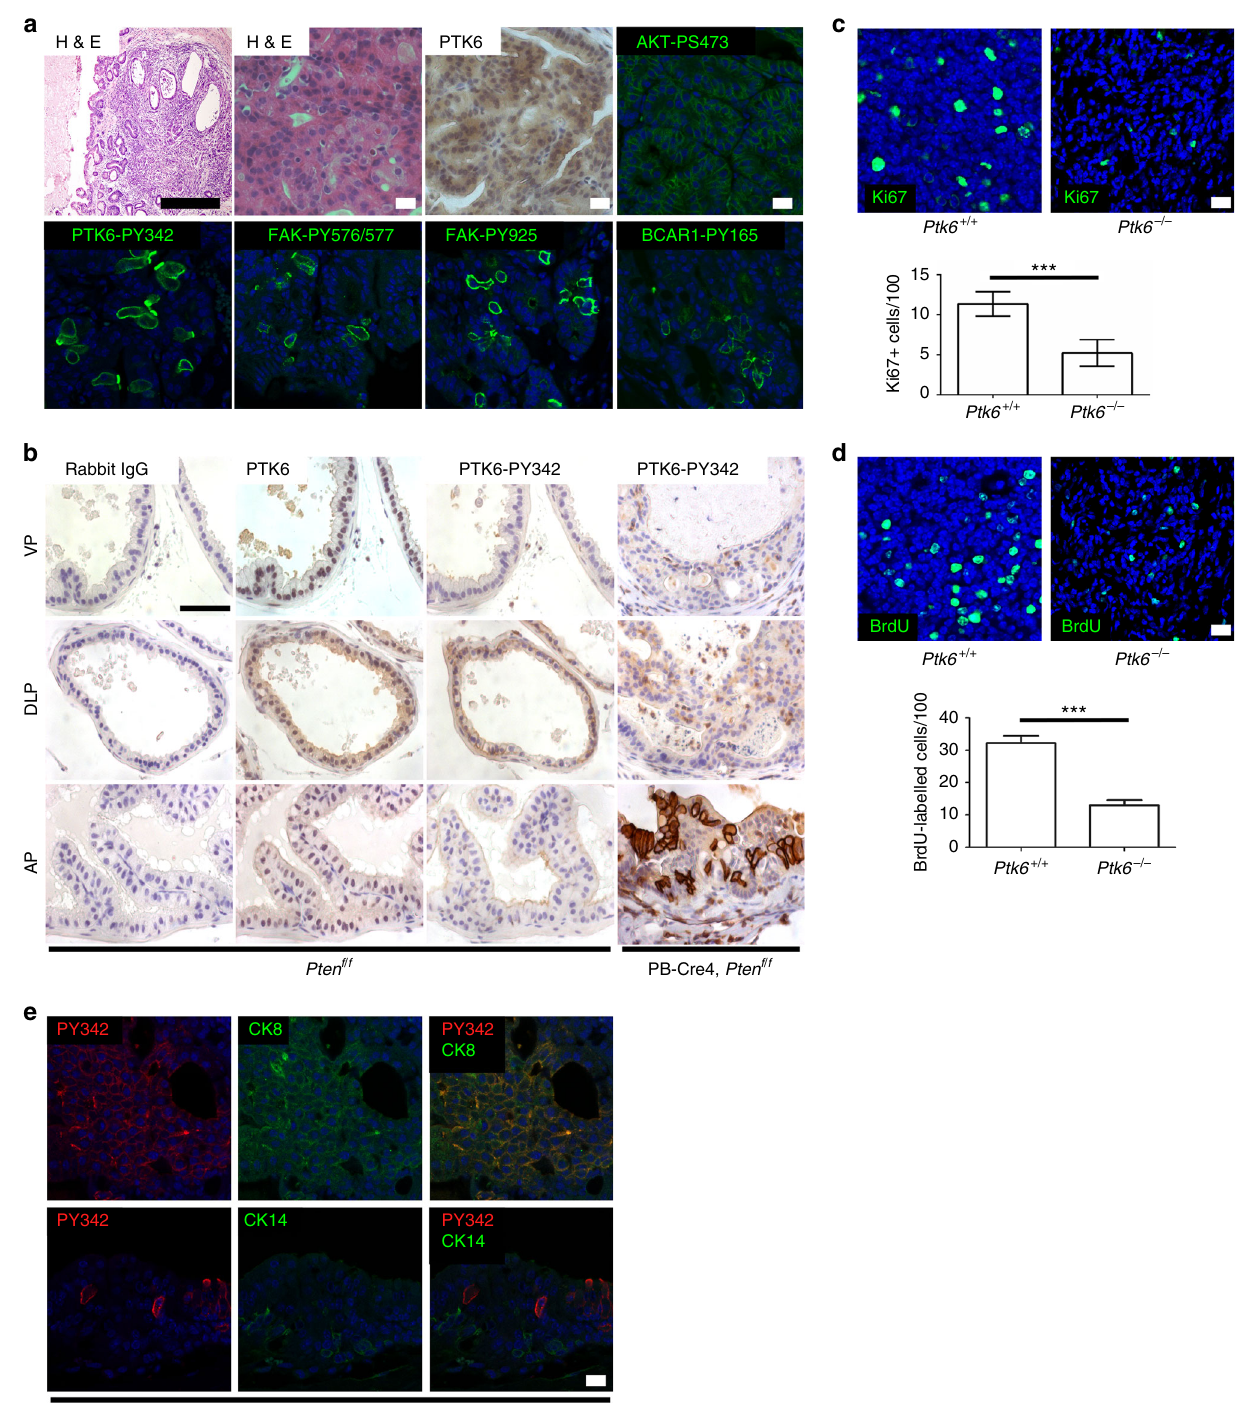
Fig. 5 PTK6 promotes tumorigenesis following PTEN loss of function. a Prostate glands from PB-Cre4, Pten fl ox/ fl ox mice were H&E stained or probed for total PTK6 (DAB, brown), active AKT (PS473, green), active PTK6 (PY342, green), active FAK (PY576/577 and PY925, green), and phospho-BCAR1 (PY165, green). Black size bar, 500 µ M; White size bar, 20 µ M. b Immunohistochemistry of PTK6 (DAB, brown) and active PTK6 PY342, (brown) in different lobes of the mouse prostate gland. VP, ventral prostate; DLP, dorsolateral prostate; AP, anterior prostate. Normal rabbit IgG was used as a negative control. Size bar, 50 µ m. c Fields of cells staining positive for Ki67 (green) in PB-Cre4, Pten fl ox/ fl ox , Ptk6 + / + and PB-Cre4, Pten fl ox/ fl ox , Ptk6 − / − mice were measured by immuno fl uorescence and quanti fi ed. Size bar, 20 µ m ( n = 6, *** P < 0.001). d Fields of cells staining positive for BrdU incorporation (green) in PB-Cre4, Pten fl ox/ fl ox , Ptk6 + / + and PB-Cre4, Pten fl ox/ fl ox , Ptk6 − / − mice were measured by immuno fl uorescence and quanti fi ed. Size bar, 20 µ m ( n = 6, *** P < 0.001). e Prostate glands from PB-Cre4, Pten fl ox/ fl ox , Ptk6 + / + were double stained for PTK6 PY342 (red) and Cytokeratin 8 (green, left panel) or Cytokeratin 14 (green, right panel). Colocalization of proteins is observed by an additive fl uorescence signal (yellow). Scale bar, 20 µ